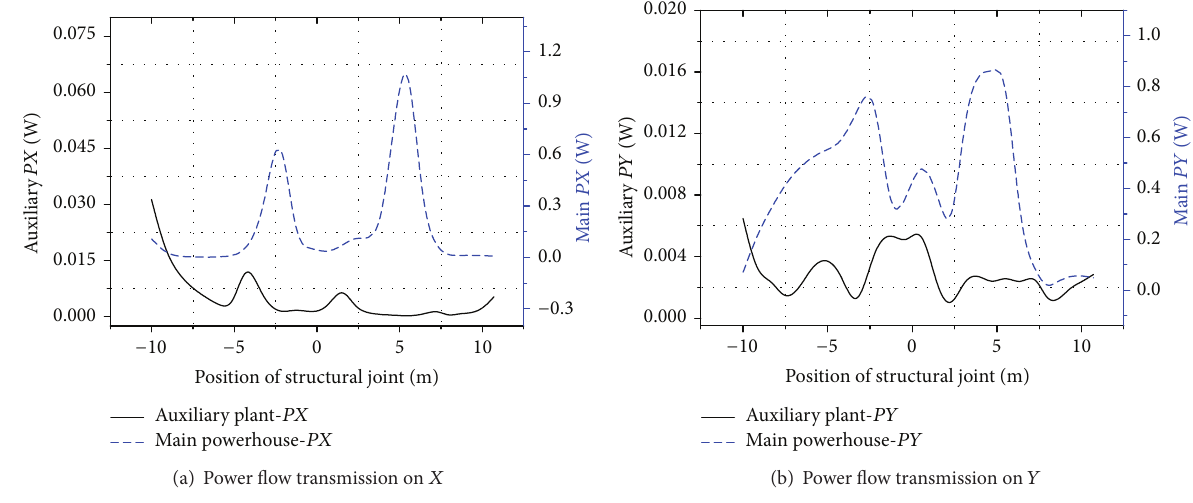
Figure 2: Dynamic transmission in structure joint at